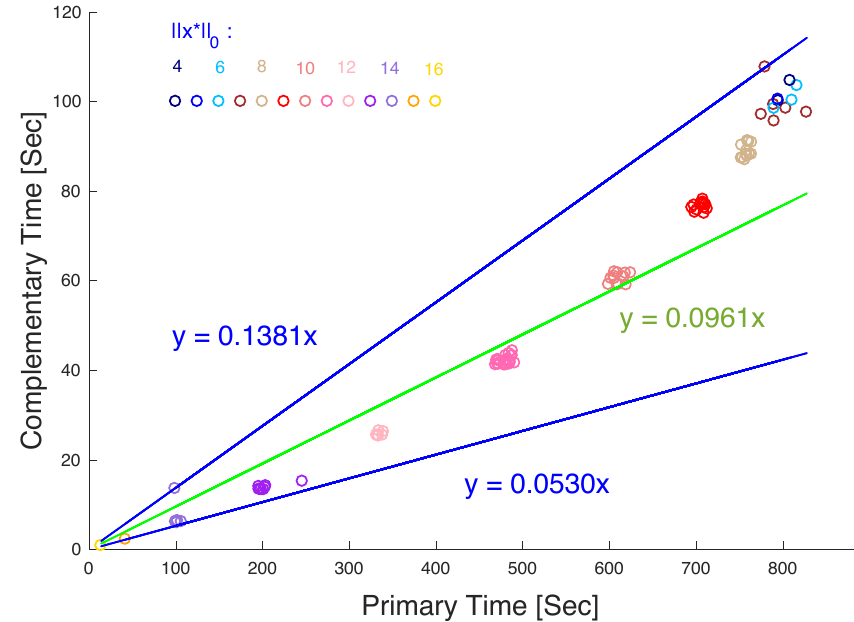
Figure 3. Performance Results: Shown in the figure are the computing times for obtaining the densest equilibrium strategies for 100 randomly generated games using the complementary vs. primary Shapley-Snow algorithms (i.e., Algorithm 5 vs. Algorithm 3). The x-axis corresponds to the time used by the primary algorithm, while the y-axis to that by the complementary algorithm. Each circle in the graph corresponds to the times required by the primary and complementary algorithms for one of the tested games. The density of the densest strategies found ranges from 4 to 16 and is color coded on the circles: The density, i.e., the richness or more specifically, the number of nonzero components of the strategy, denoted as (cid:107) x ∗ (cid:107) 0 , increases in the order of 4, 5, 6, 7, 8, 9, 10, 11, 12, 13, 14, 15, 16, as the color of the circle changes in the order of dark blue, blue, light blue, brown, light brown, red, light red, pink, light pink, purple, light purple, orange, light orange, respectively. Note also that all the circles are above the line y = 0.0530 x and below y = 0.1381 x , showing that the computation time by the complementary algorithm can be as small as 5.3 percent of the time by the primary algorithm, and at most 13.81 percent. On average, the former is about 9.61 percent of the latter, as indicated by the median line y = 0.096 x